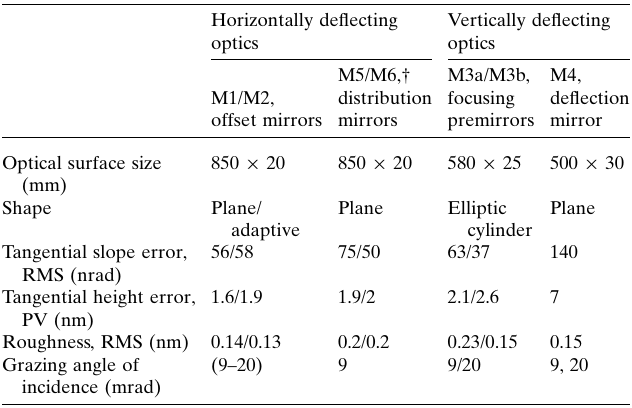
Table 2 Optical elements of the SASE3 beamline: